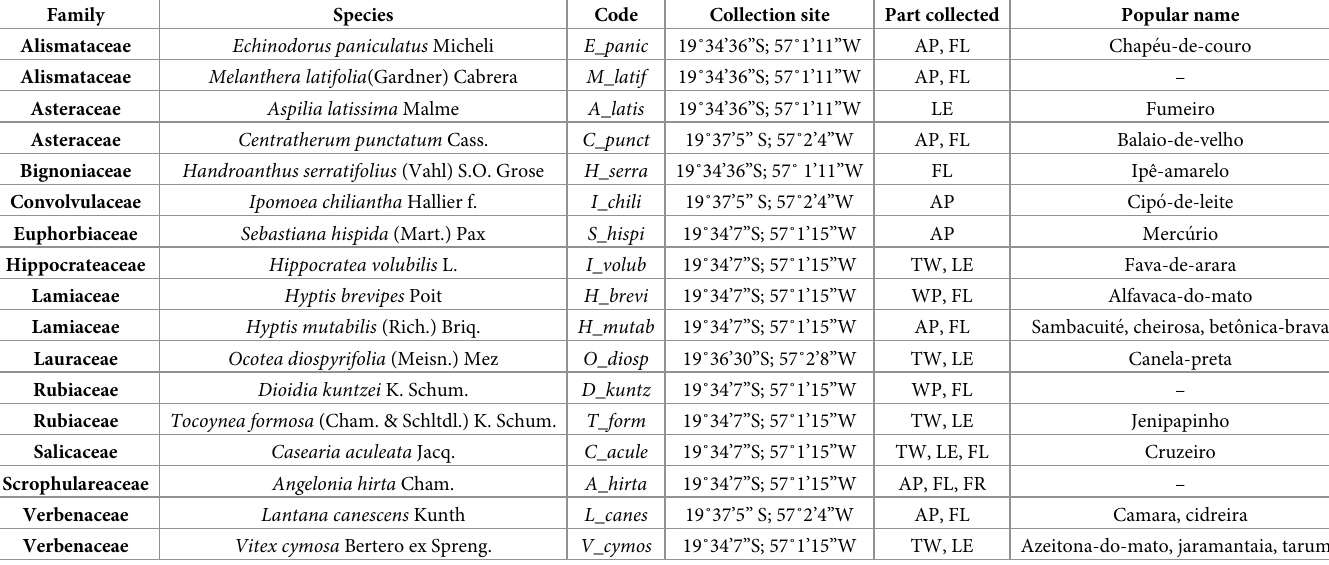
Table 1. Families, species, code, collection sites, parts collected and popular names of plants evaluated for ovicidal activity against Haemonchus placei